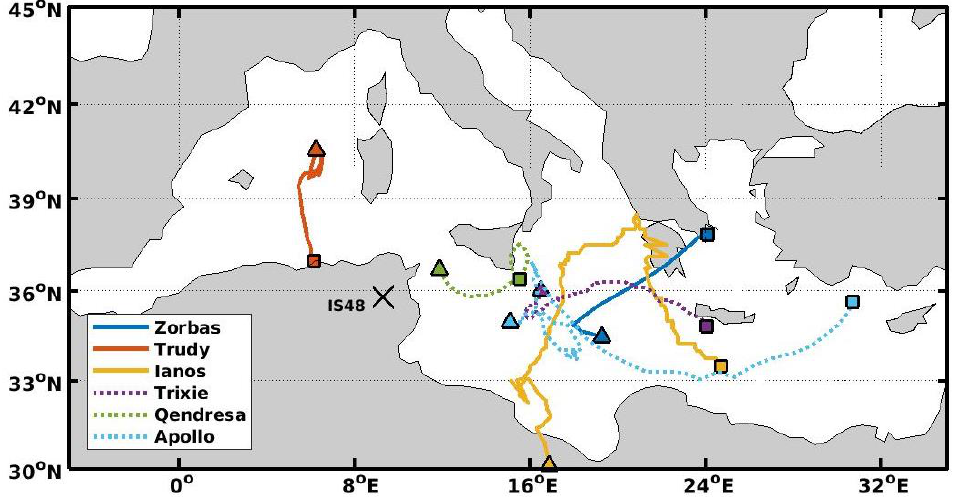
Figure 1. Trajectories of the medicanes considered in the study and presented in Section 2.6. Markers indicate the beginning of the recorded trajectory (triangle) as well as the end of it (square). The black cross shows the location of the infrasound station IS48 in Tunisia. The trajectories drawn with a solid (resp. dotted) line indicate medicanes for which significant infrasound detections could (resp. not) be observed at the station, at least in one of both frequency ranges considered in the paper.